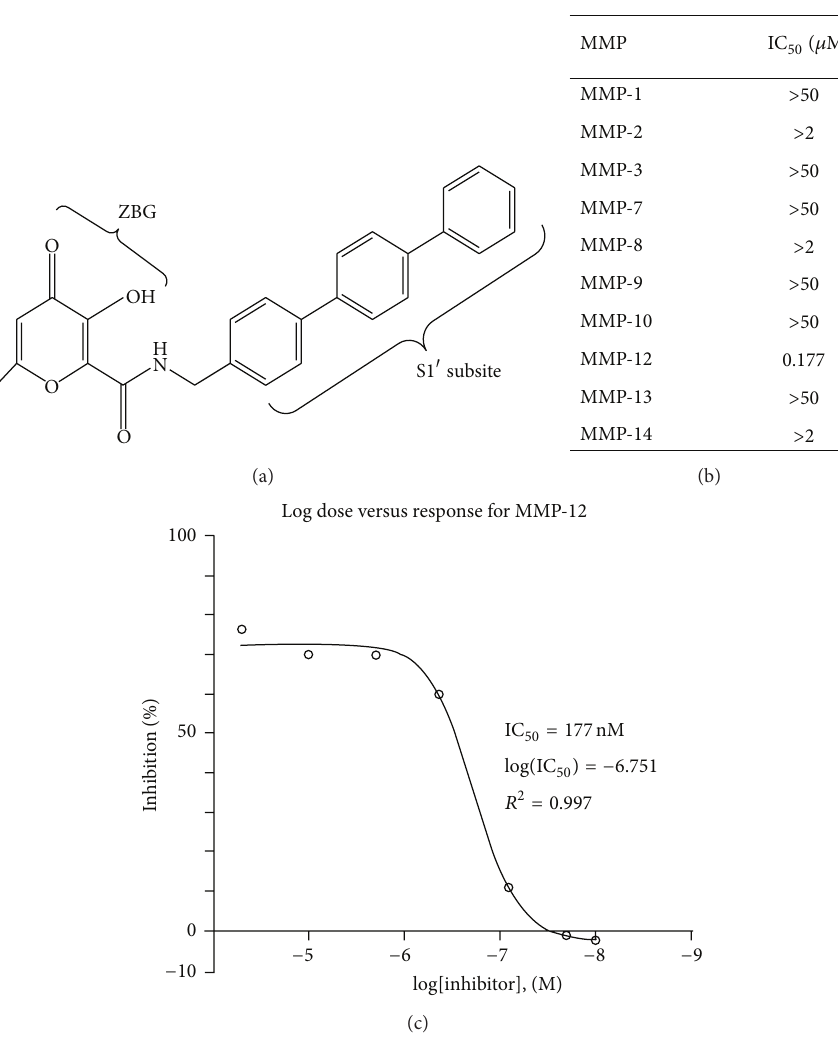
Figure 1: Chemical structure and specificity of the synthesized MMP inhibitor. (a) The target compound consists of a Zn 2+ -binding group (ZBG) and a terphenyl which resides in the deep S1 󸀠 pocket of the MMP catalytic domain [21]. (b) List of in vitro determined IC 50 values ( 𝜇 M) which indicates that the inhibitor is very specific towards MMP-12 with an IC 50 in the nanomolar range. (c) Fitted dose-response curve relation to MMP-12 used to calculate the IC 50